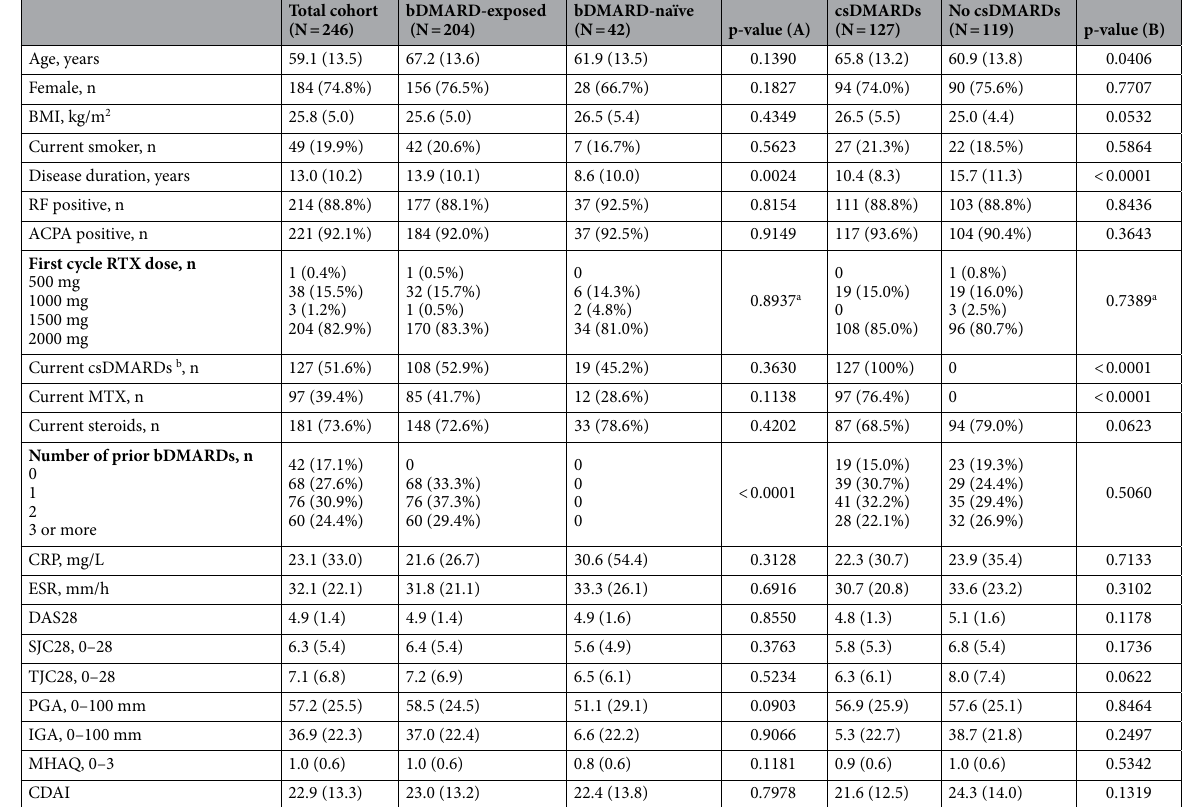
Table 1. Group characteristics at baseline. Continuous data are presented as the means with standard deviations (SD), and categorical variables are presented as numbers and percentages. (A) p-value < 0.05 between bDMARD-exposed and bDMARD-naïve subgroups; (B) p-value < 0.05 between csDMARD and no csDMARD subgroups. CRP C-reactive protein, ESR erythrocyte sedimentation rate, SJC28 28 swollen joint count, TJC28 28 tender joint count, DAS28 disease activity score with 28 joint counts, CDAI clinical disease activity index, PGA patient global assessment, IGA investigator global assessment, MHAQ